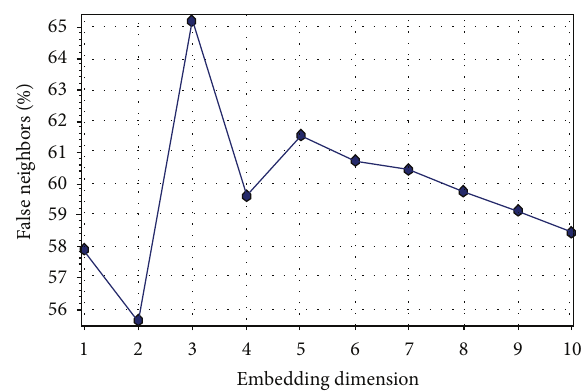
Figure 4: Calculated process of optimal embedding dimension.